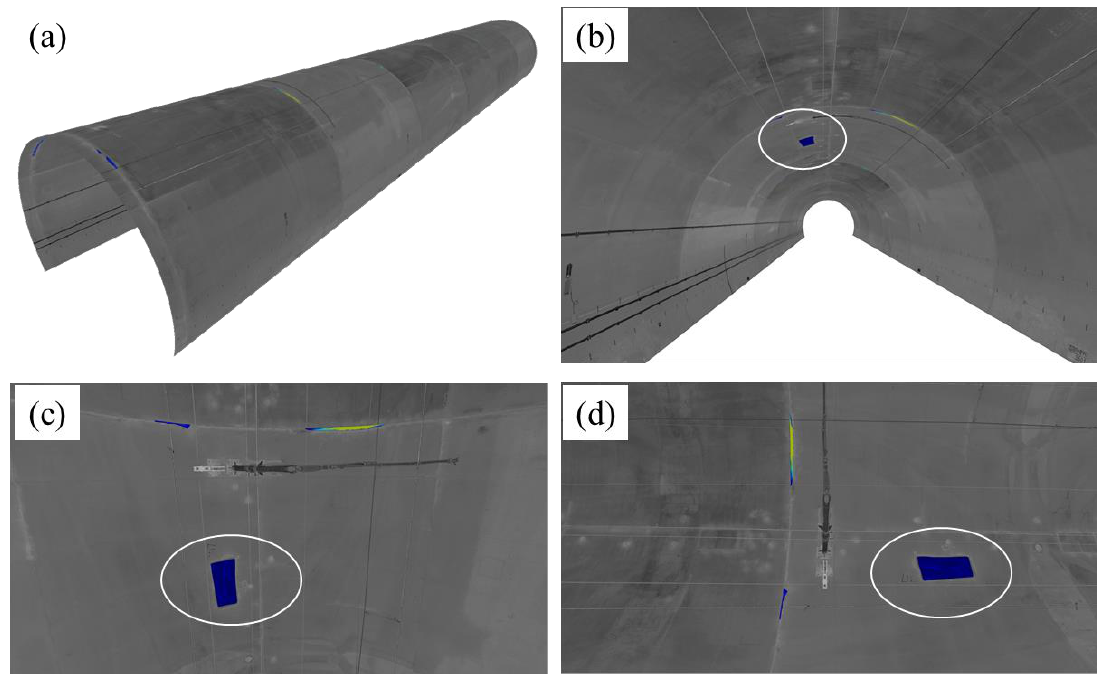
Figure 19. 3D visualization results from several viewing perspective of the detected spalling defects including: ( a ) overall view, ( b ) longitudinal view, and ( c , d ) front view; a specific spalling defect is highlighted with white circles from different viewing perspective. Table 3. Inspection report for spalling defects from a 75 m long tunnel section.